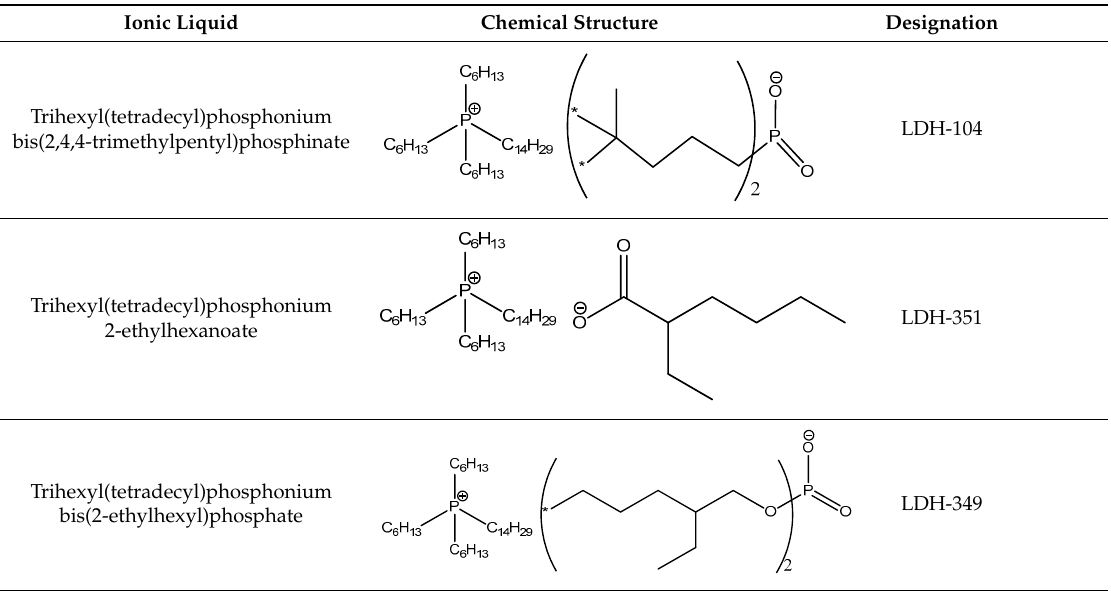
Table 3. Designation of ionic liquids (ILs) used for the surface treatment of layered double hydroxide (LDH).